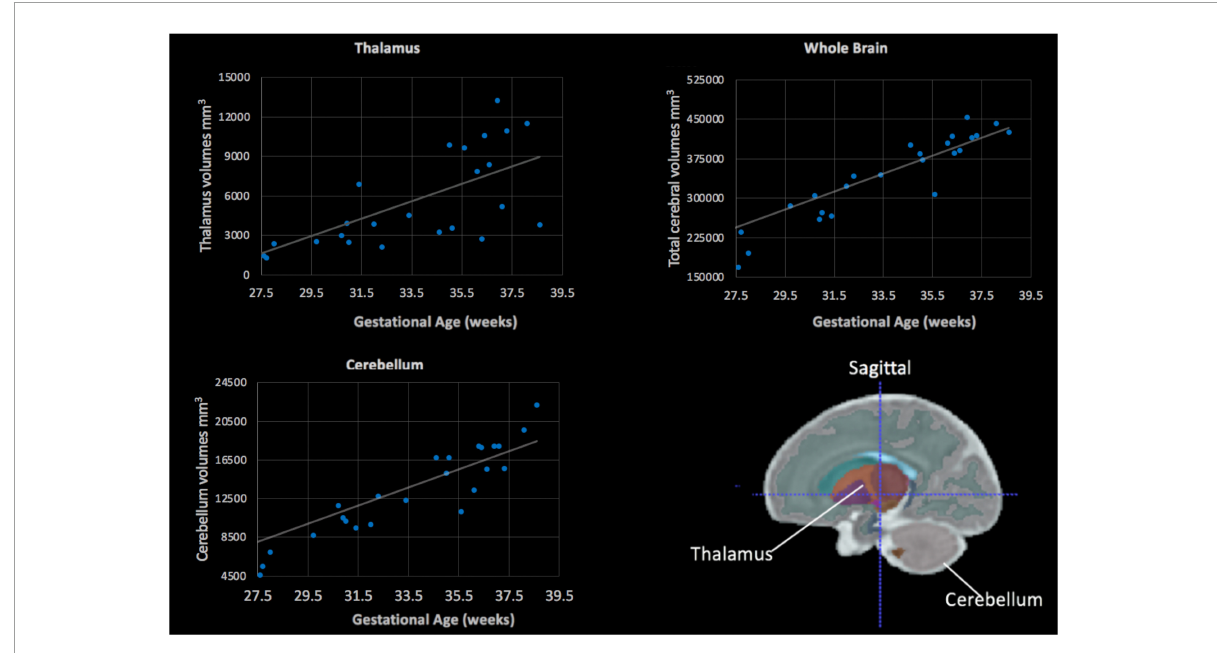
FIGURE5 Fetal subcortical volumes ( y -axis) plotted in relation to gestational age ( x -axis). Fetal thalamus (top, left) , whole brain (top, right) and cerebellum (bottom, left) volumes were plotted in relation to gestational age in weeks. The cerebellum, thalamus and total cerebral volumes showed a positive linear association with gestational age (all, p < 0.05). (Bottom, right) The color-coded fetal atlas overlaid on a atlas MRI demonstrates the location of the thalamus (orange/purple) and the cerebellum